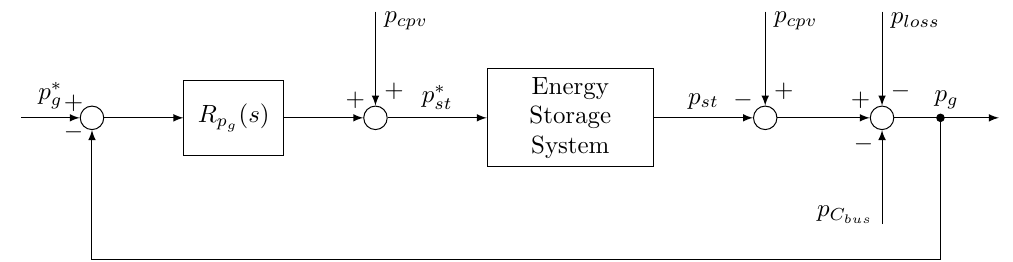
Figure 7. Closed-loop scheme for the control of the active power injected into the grid.